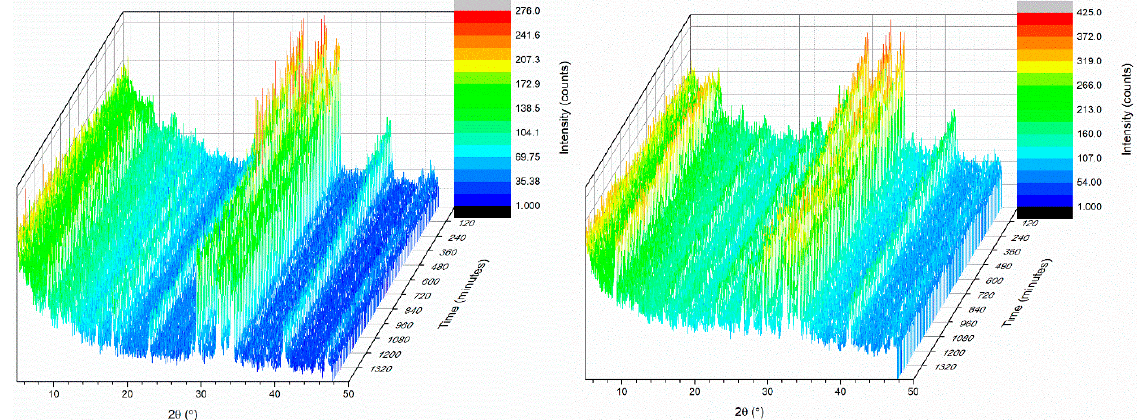
Figure 5. X-ray patterns of C0 ( left ) and C45 ( right ) samples, registered from t 0 up to 24 h. Table 2. Composition of the C0 and C45 pastes determined from the XRD patterns. The phase analysis allowed the identification of the main compounds of C0 (C 3 S, C 2 S,